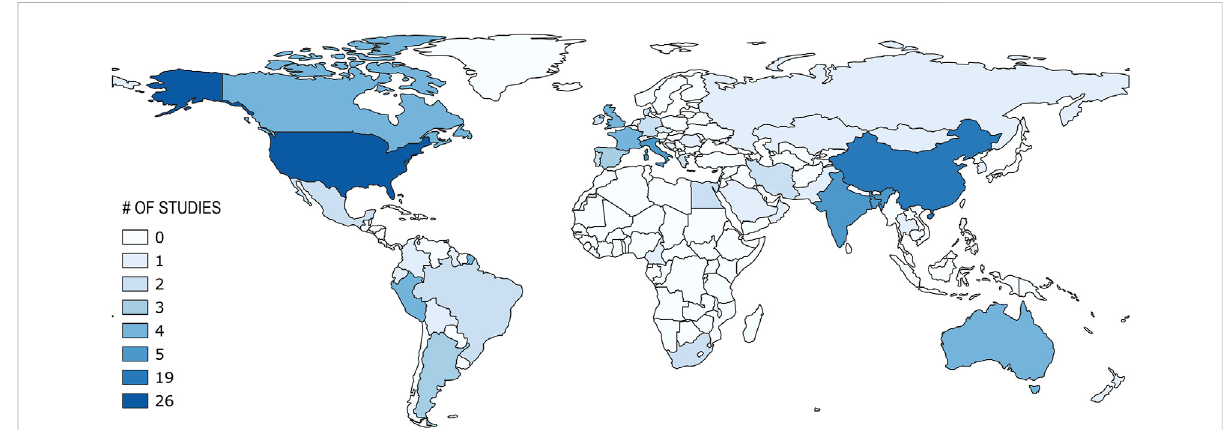
FIGURE 3 The number of extreme event studies by country. Note that 40 articles in our literature sample had a “ global ” focus and are included in the counts here, making the minimum count for any particular region 40. Studies of inter-country regions (e.g., the Mediterranean) were excluded.